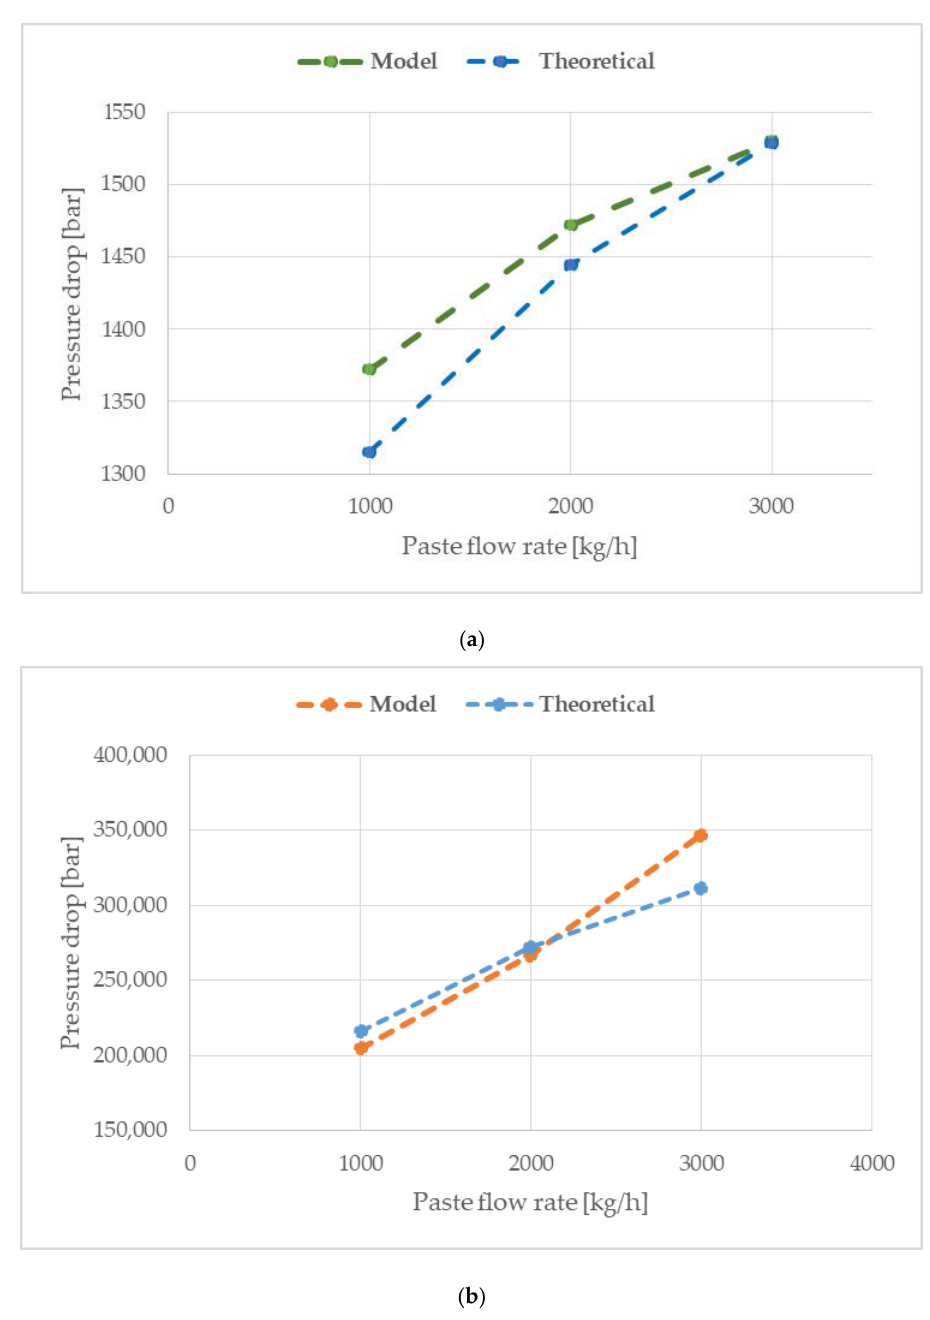
Figure 3. Validation of the model—( a ) pressure drop; ( b ) heat transfer coefficient.